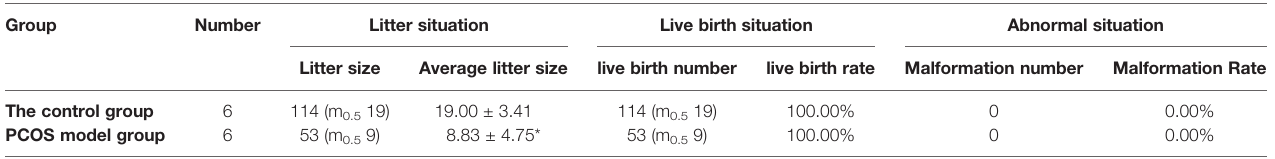
TABLE 4 | The live births of progeny in rats.